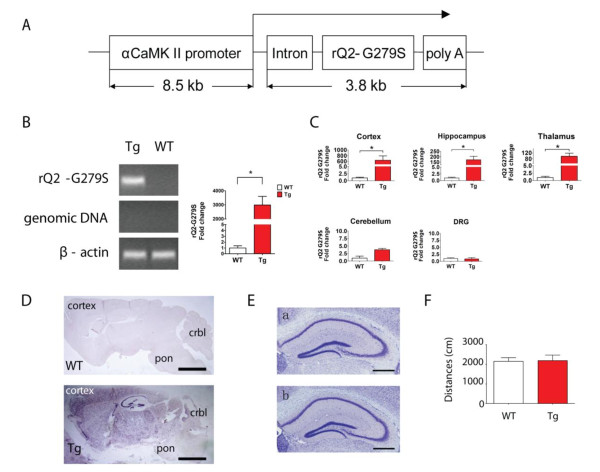
Generation and confirmation of transgenic mice overexpressing the KCNQ2 dominant-negative pore mutant in forebrain. A. Schematic organization of the transgene for forebrain-specific expression of the dominant-negative mutant of rat KCNQ2-G279S (rQ2-G279S) driven by the αCaMKII promoter. B. Identification of rQ2-G279S mRNA in the brain isolated from transgenic (Tg) and wild type (WT) mice by real time RT-PCR (mean ± s.e.m., n = 4, *p < 0.05). The template of rQ2-G279S specific primers for detection of KCNQ2 mutant gene expression is located in the area of SV40 poly A of the 265-plasmid (transgenic construct). The template of genomic DNA primers for detection of genomic DNA contamination is located after SV40 poly A in the 265-plasmid (transgenic construct), which does not undergo transcription. β-actin is used as an internal reference. C. Expression of rQ2-G279S mRNA isolated from 5 different tissues of WT and Tg mice by real time RT-PCR. The transgene rQ2-G279S was adequately expressed in the cortex, hippocampus and thalamus, with little expression in the cerebellum, and was not expressed in the DRG of Tg mice (mean ± s.e.m., n = 4, *p < 0.05). D. Expression of rQ2-G279S mRNA of WT (top) and Tg mice (down) using in situ hybridyzation. The transgene rQ2-G279S was adequately expressed in the cortex, hippocampus, and thalamus, with little expression in the cerebellum (crbl) and pons, and was not expressed in the medulla of Tg mice. The scale bar is 2mm. E. Nissl-stained coronal sections of hippocampus. No obvious structural change was found in adult transgenic mice (a) or wild type littermates (b). Scale bar, 500 μm. F. Locomotor activity test, no significant difference was detected in wild type (WT) and transgenic mice (Tg) in the total distance traveled during a period of 30 minutes (mean ± s.e.m., n = 7).